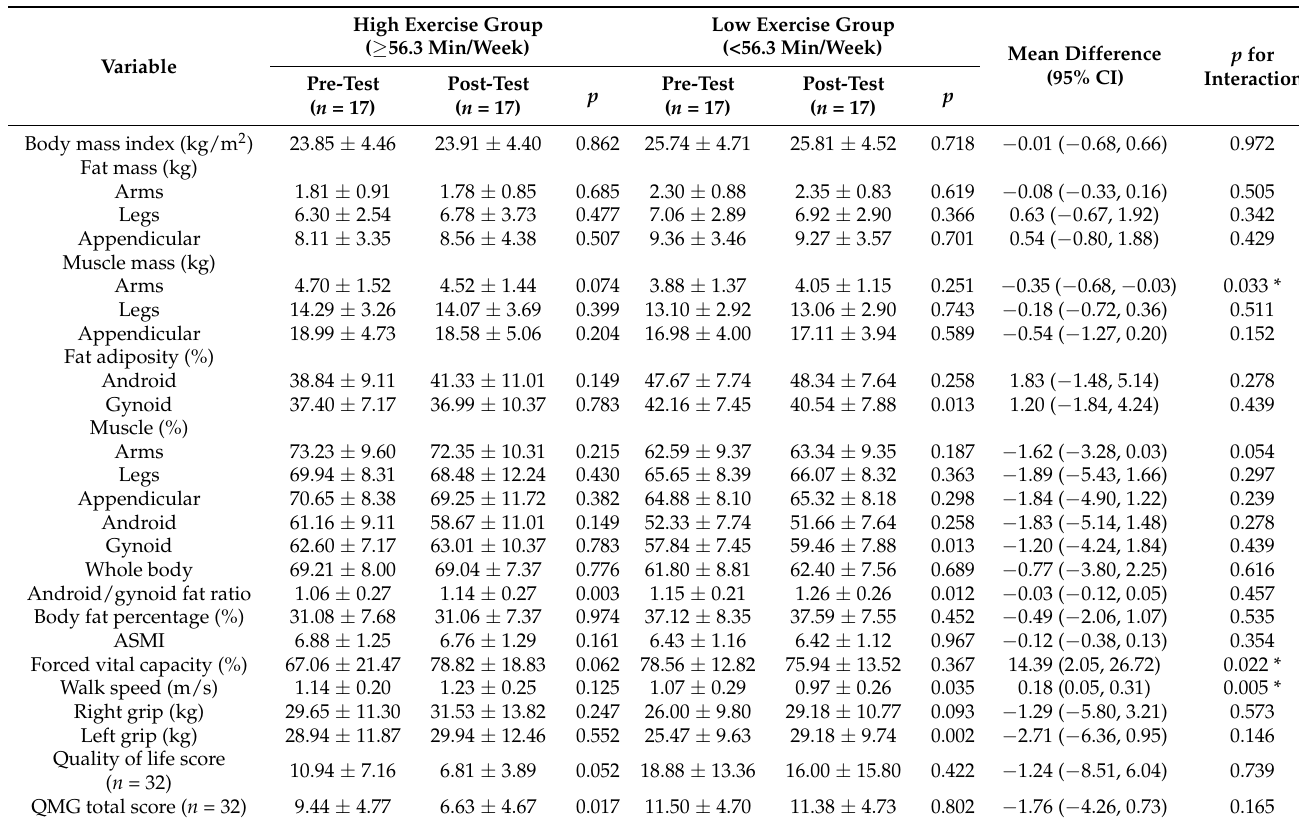
Table 3. Body composition of patients with MG before and after resistance training according to the time spent exercising per week (by median).